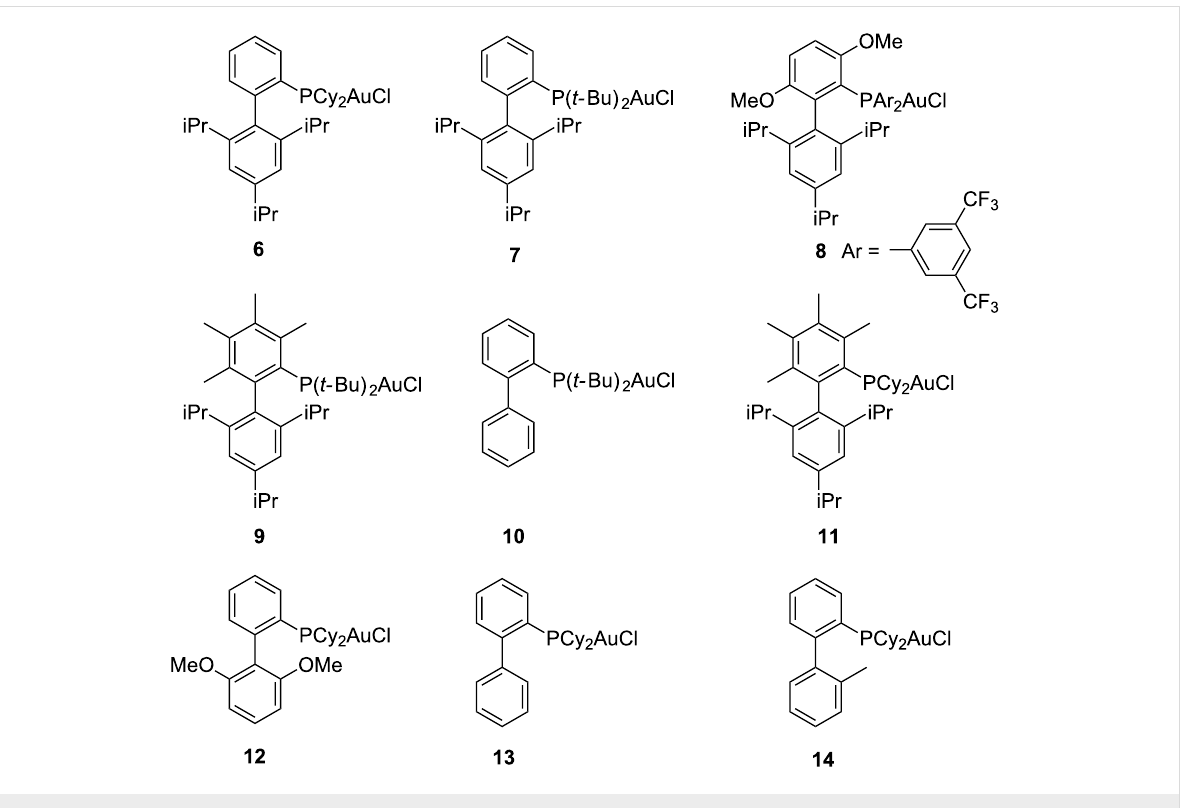
Figure 1: Gold complexes used in this